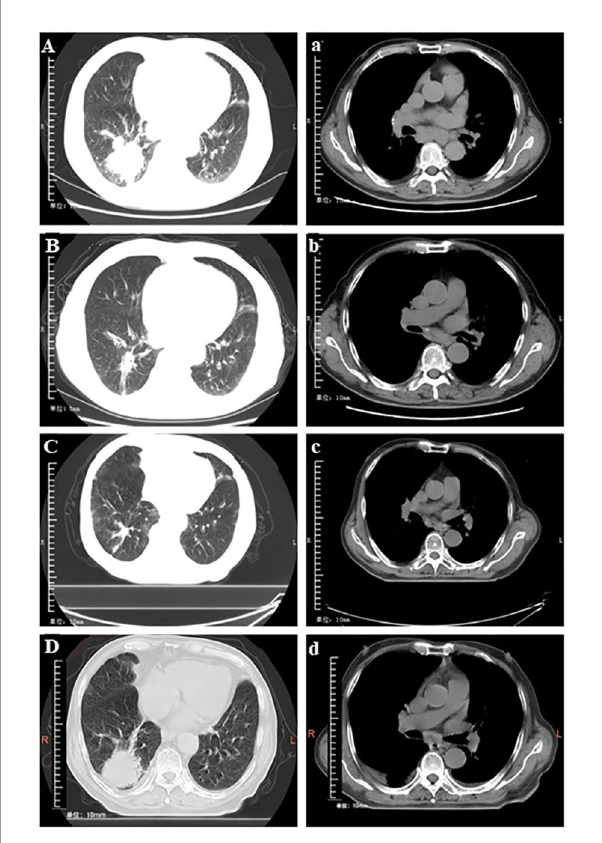
FIGURE 2 Conversion of chest computed tomography at different times. ( A and a ) Baseline fi ndings on chest computed tomography (tumor size: 52 × 55 mm). ( B and b ) The mass shrank signi fi cantly (tumor size: 31 × 18 mm) after treatment with four cycles of anlotinib plus cisplatin. ( C and c ) Stable disease (tumor size: 25 × 21 mm) following 12 cycles of anlotinib + tegafur. ( D and d ) Progressive disease (tumor size: 41 × 34 mm) after 29 cycles of anlotinib +